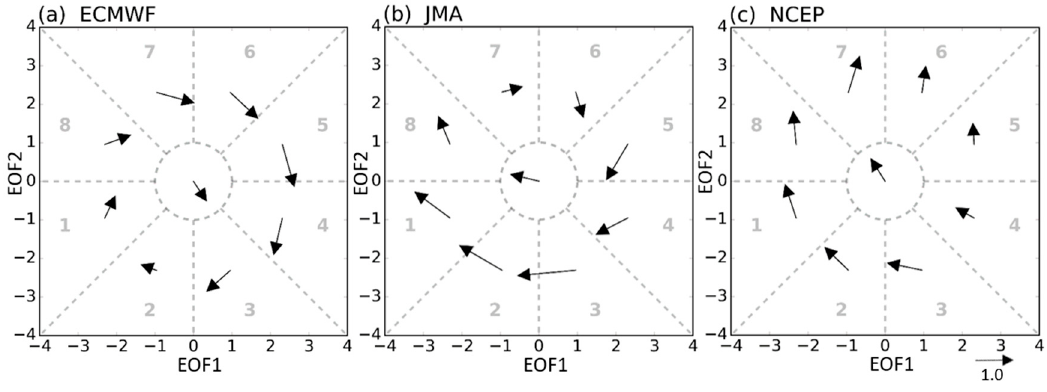
Figure 4. The error vector at 10-day lead time averaged over forecasts initially located in each MJO phase for ( a ) ECMWF, ( b ) JMA and ( c ) NCEP models. The magnitude of the error vector is as measured by the scale (bottom left).